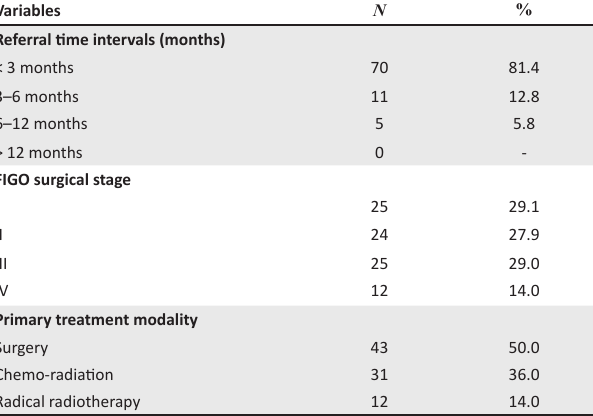
n = 86. FIGO, International Federation of Gynaecology and